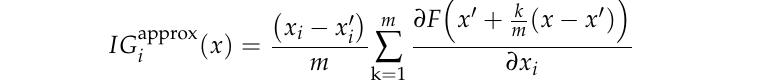
Figure 13. The evolution of the gene corresponding to ( a ) 𝜉 (cid:2868) and 𝜉 (cid:2998) in the phenomenological CP model and ( b ) 𝜏 (cid:2868) and 𝑖 (cid:3046) in the dislocation-density-based CP model.